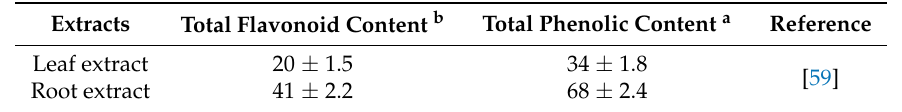
Table 3. Total flavonoid (aluminium chloride colorimetric method by [64] and phenolic content (Folin–Ciocalteu reagent method by [65] of root and leaf extracts of G. kurroo